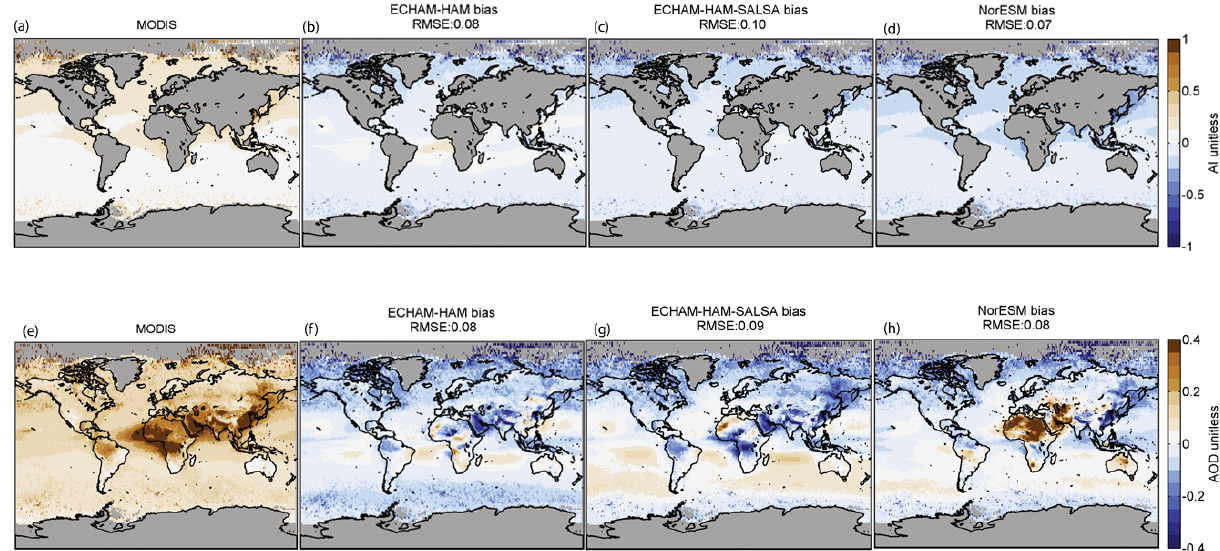
Figure 5. Aerosol index (AI) (b–d) and aerosol optical depth (f–h) annual mean bias. AI values are representative of ocean values only. The bias represents the difference between the model direct outputs and MODIS observations. High latitudes (lat > 60 ◦ N or lat > 60 ◦ S) are excluded in the computation of the root mean square error (RMSE). MODIS spatial distribution is presented as reference (a, e)